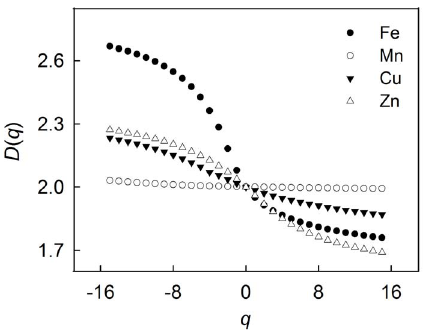
Figure 2. General fractal dimension D ( q ) for selected soil trace elements at 2 15 to 15 range of q evaluated at 1 increment.